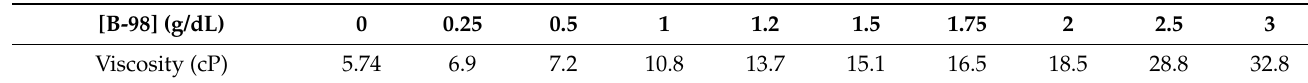
Table 4. Viscosity of B98-benzyl alcohol solutions.